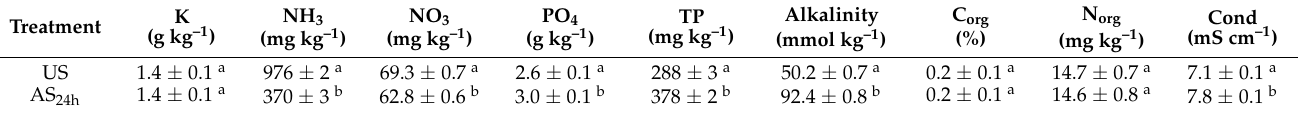
Table 1. Chemical–physical characteristics of untreated (US) and aerated (AS) slurry. Data are means ( n = 5) ± SE.